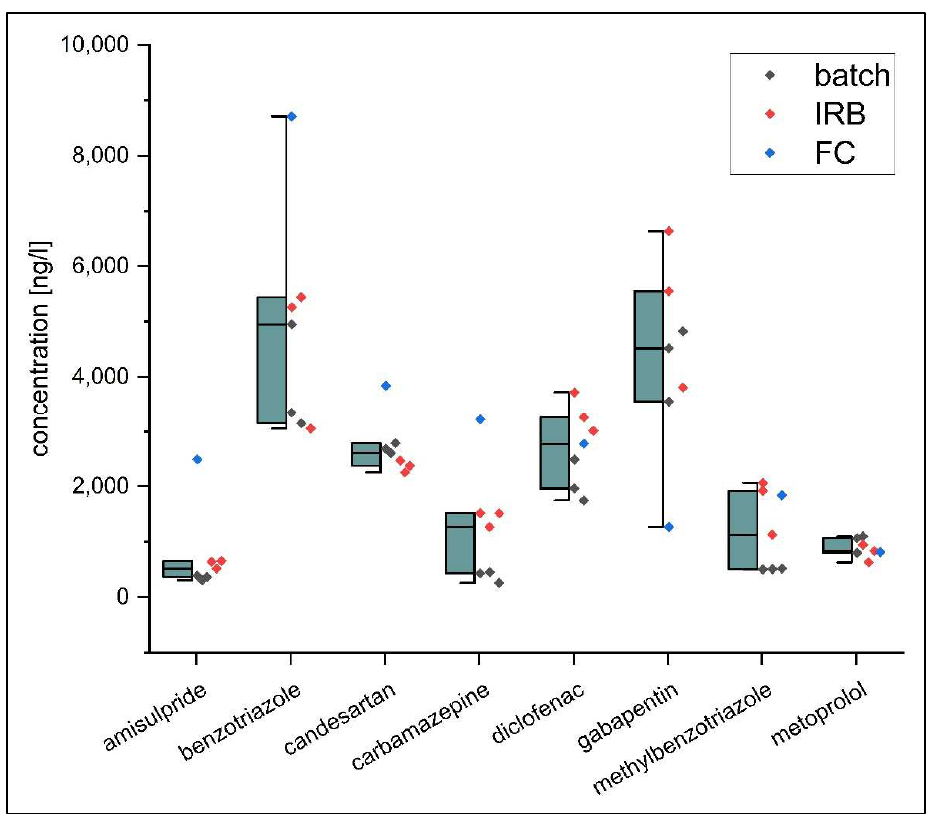
Figure 5. Initial concentrations of micro-pollutants shown as boxplot and individual data point for all experimental steps measured in samples of the secondary effluent of the Weimar-Tiefurt treatment plant (IRB: immersion rotary body reactor; FC: flat cell reactor).